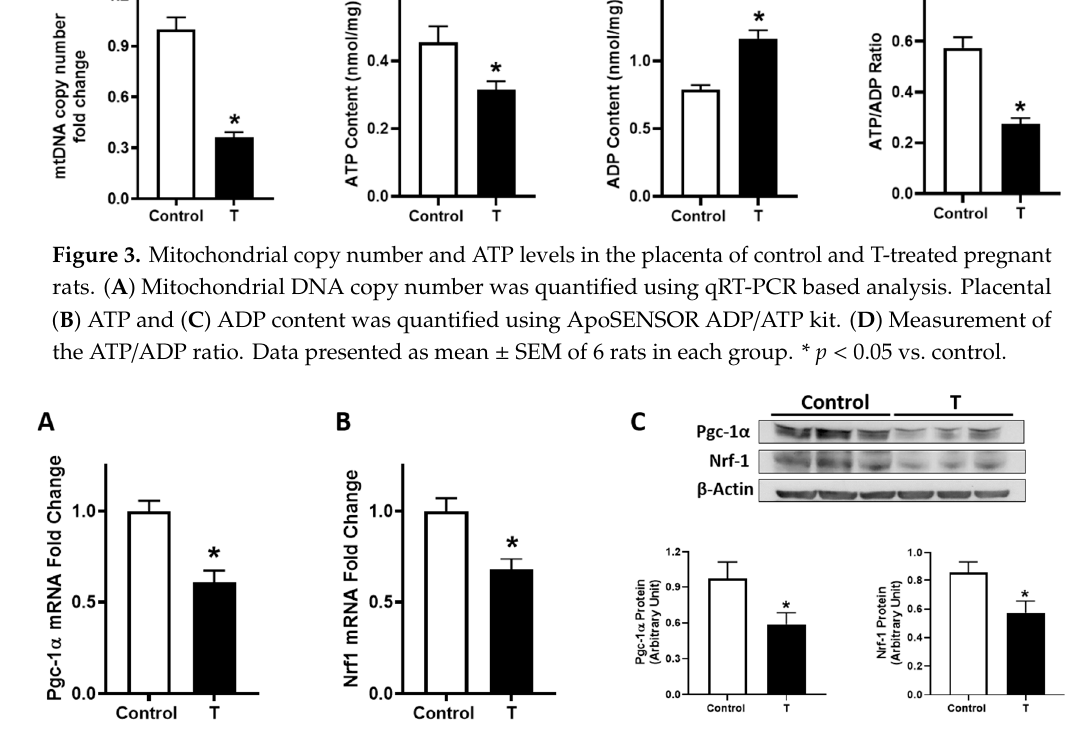
Figure 3. Mitochondrial copy number and ATP levels in the placenta of control and T-treated pregnant rats. ( A ) Mitochondrial DNA copy number was quantified using qRT-PCR based analysis. Placental ( B ) ATP and ( C ) ADP content was quantified using ApoSENSOR ADP/ATP kit. ( D ) Measurement of the ATP/ADP ratio. Data presented as mean ± SEM of 6 rats in each group. * p < 0.05 vs. control.